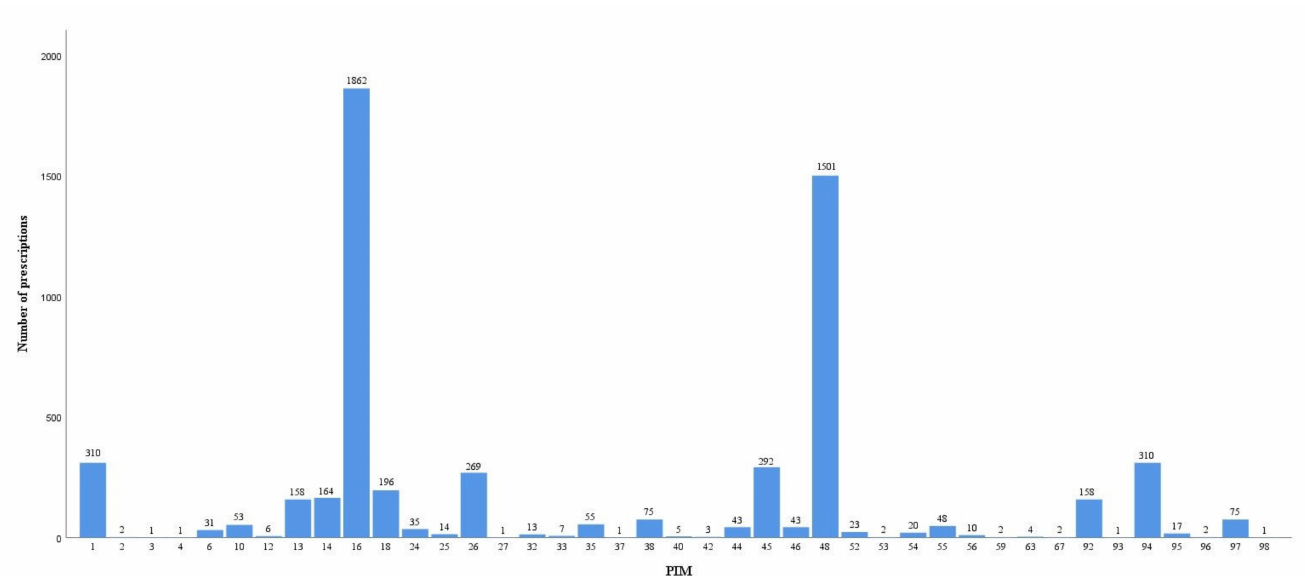
Figure 3. The number of prescriptions in each PIM.